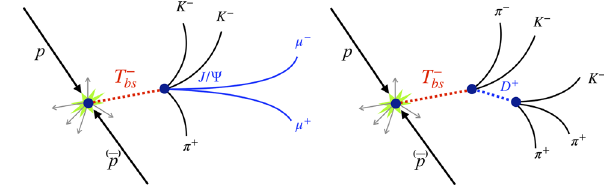
Fig. 2 Depicted diagrams of the weak decays of the below-threshold bs ¯ u ¯ d tetraquark − that T and T 0 are the state of J P = 0 + with the ¯ u cs bs